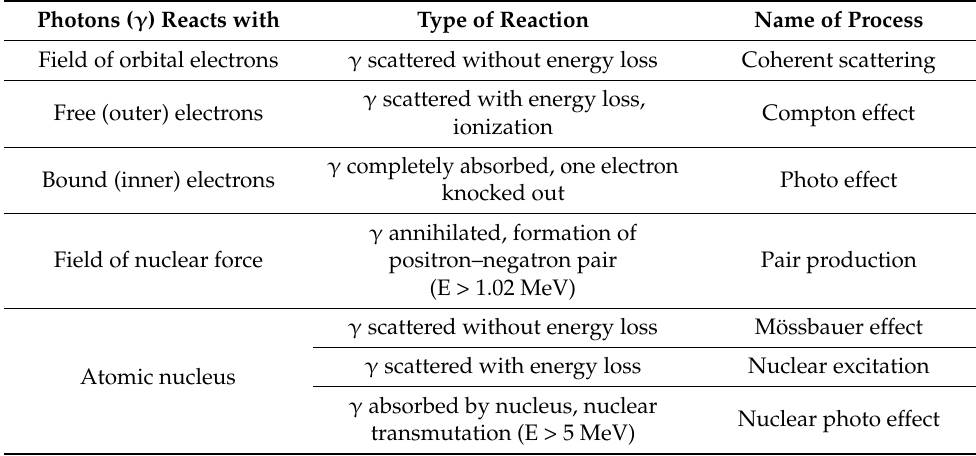
Table 1. Nuclear gamma radiation absorption processes.